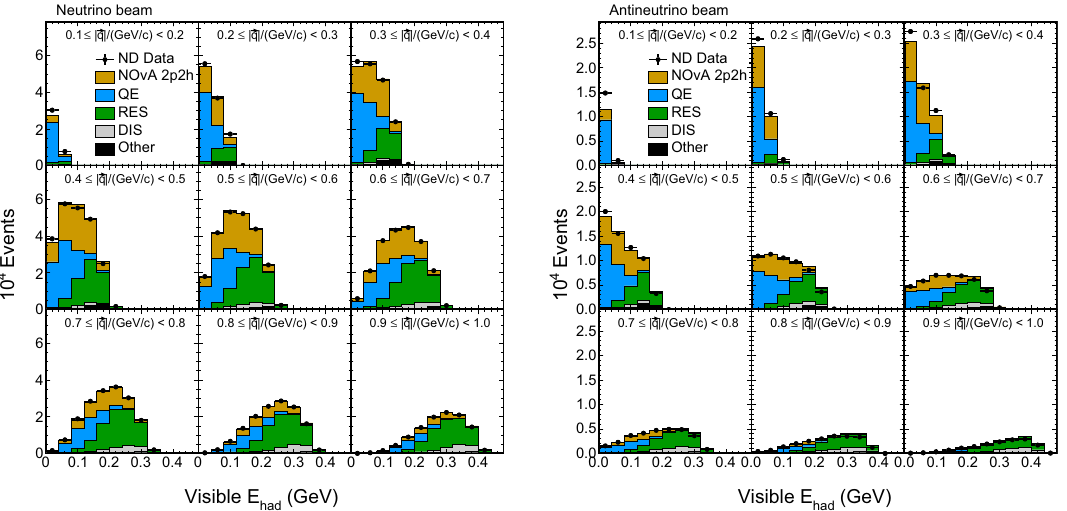
Fig. 8 Comparison of fully adjusted simulation to ND data in reconstructed visible hadronic energy for neutrinos (left) and antineutrinos (right). The panels show 0 . 1 GeV/c wide bins of reconstructed momentum transfer from 0.1–0.2 GeV/c (upper left) to 0.9–1.0 GeV/c (lower